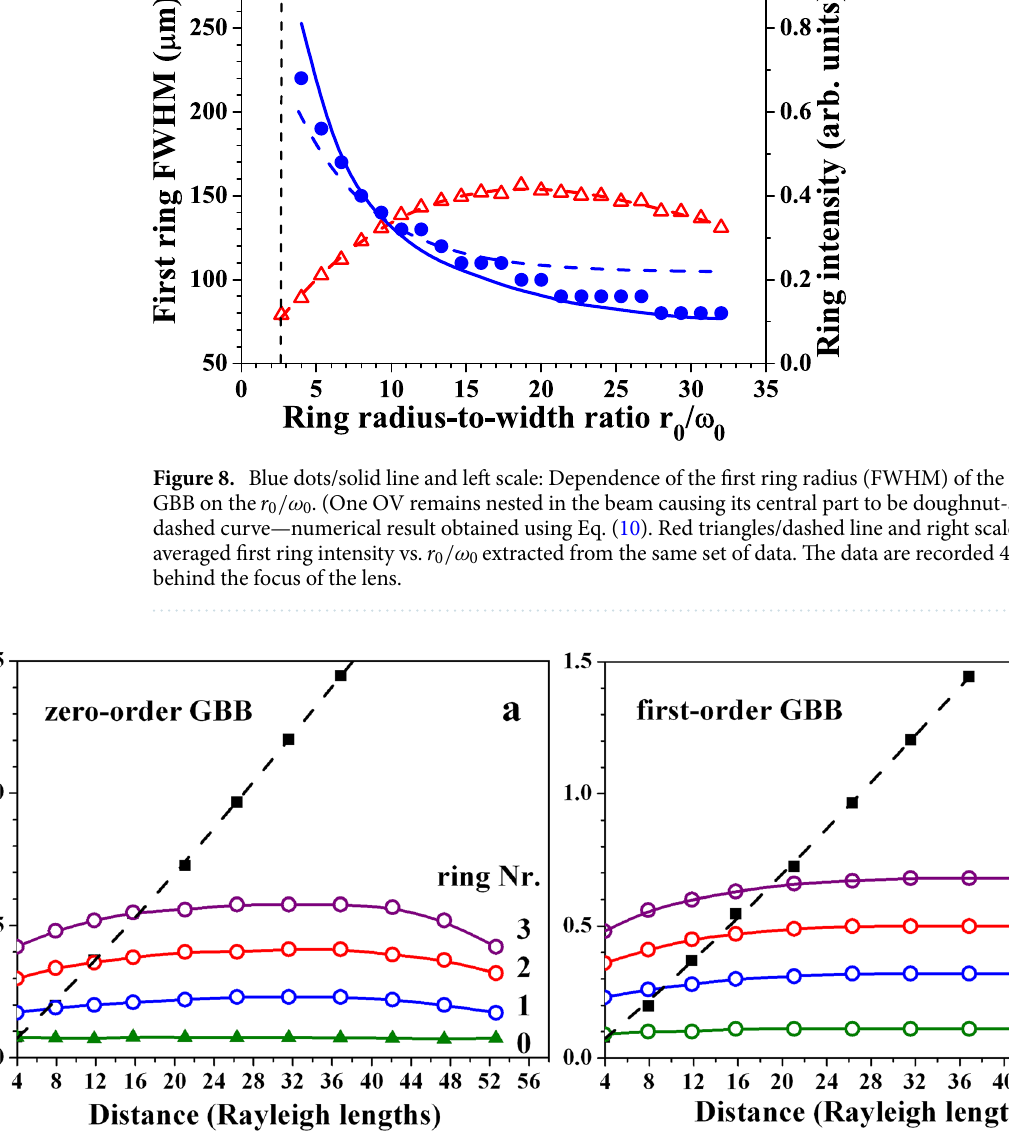
Figure 9. Direct comparison between the width of the central peak for zeroth-order GBB and the positions of the first coaxial bright rings (graph (a) ) and respective data for first-order GBB (graph (b) ) vs. free space propagation distance in units of Rayleigh lengths ( z R = 3.8 cm). Black solid squares and dashed line-width of the pure Gaussian beam when the two SLMs are switched